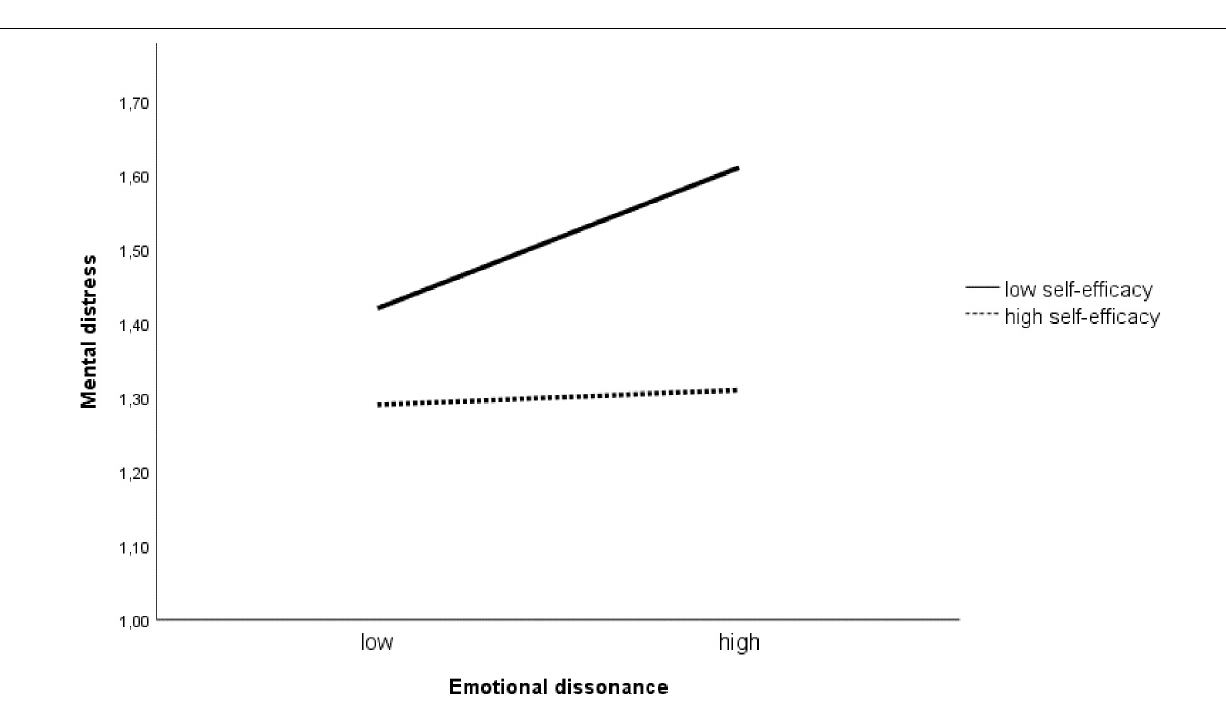
FIGURE 3 | The moderating effect of self-efficacy on the relationship between emotional dissonance and mental distress ( n =